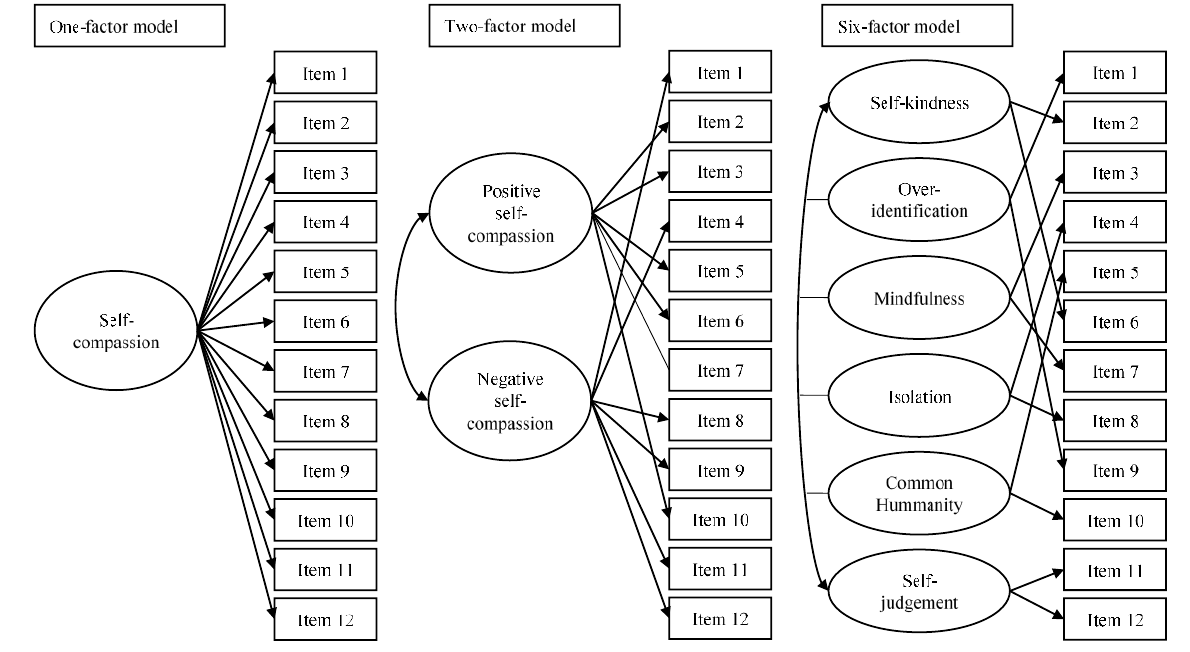
Figure 1. CFA models assessed for the validation of the Self-Compassion Scale — Short Form (SCS-SF).